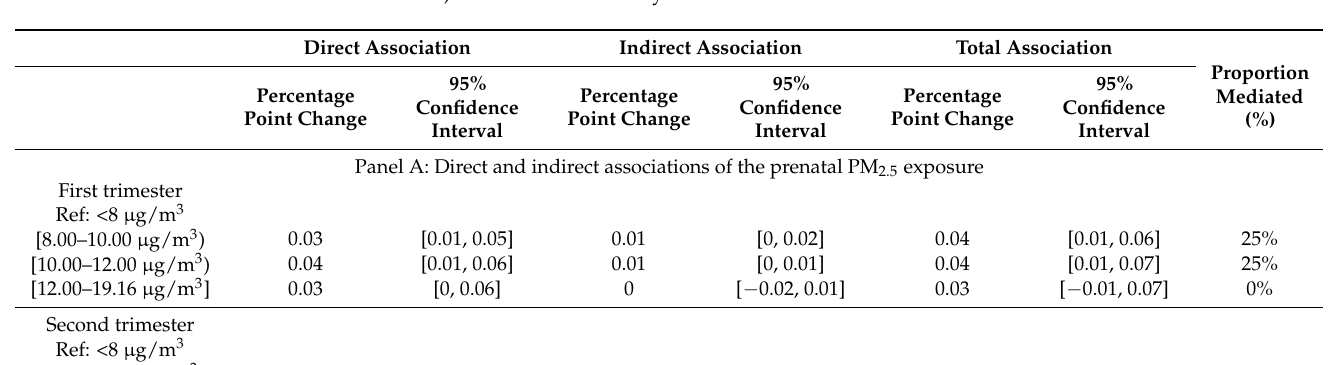
Table 3. Direct and indirect associations of prenatal and post-birth PM 2.5 exposure (defined over 12 months) with infant mortality.